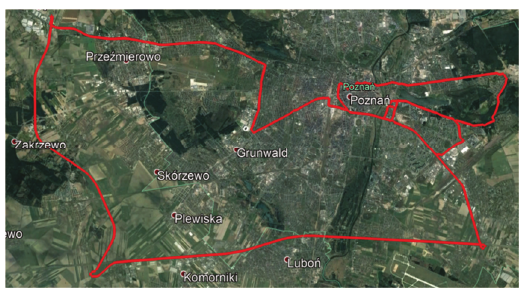
Fig. 4. The research route in accordance with the procedure RDE Table 2. RDE cycles data